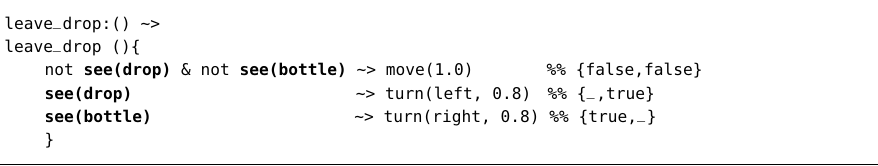
Table 5. From TeleoR percept/belief (up) to Erlang equivalent (down): bottle collecting robot.